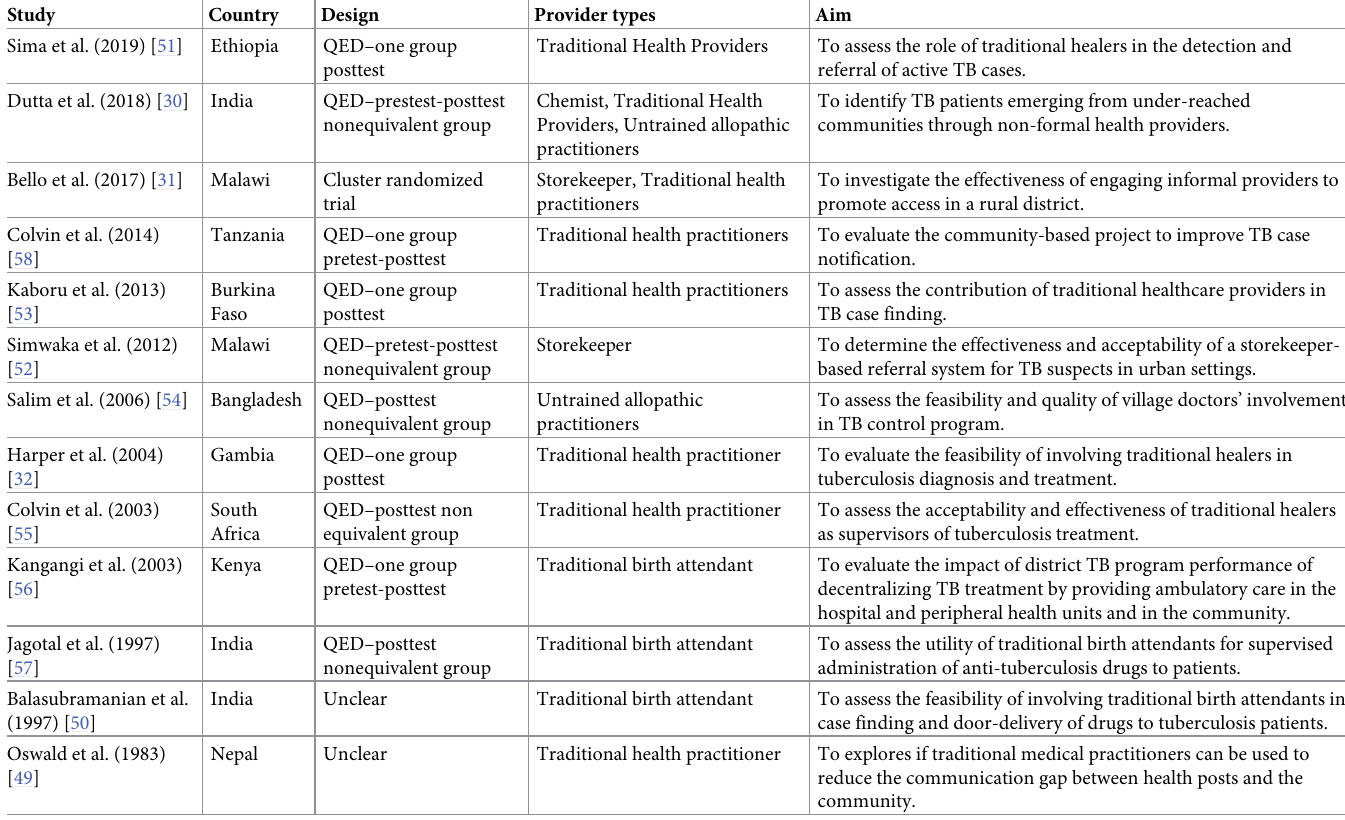
Table 1. Characteristics of included studies (n =